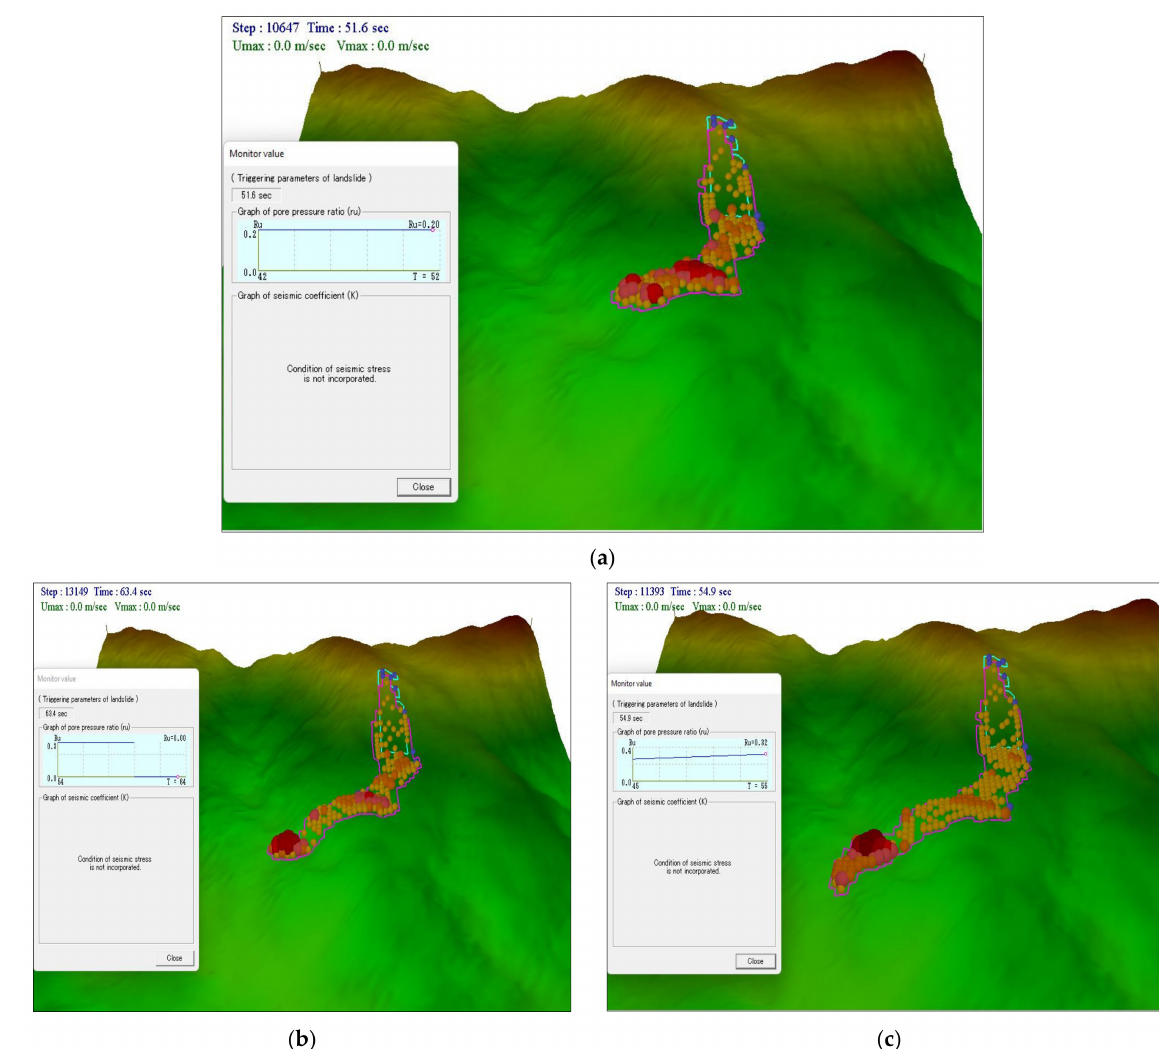
Figure 13. Numerical simulation for fixing the optimum pore water pressure ratio (r u ): ( a ) 0.2r u ; ( b ) 0.3r u ; and ( c ) 0.32r u .